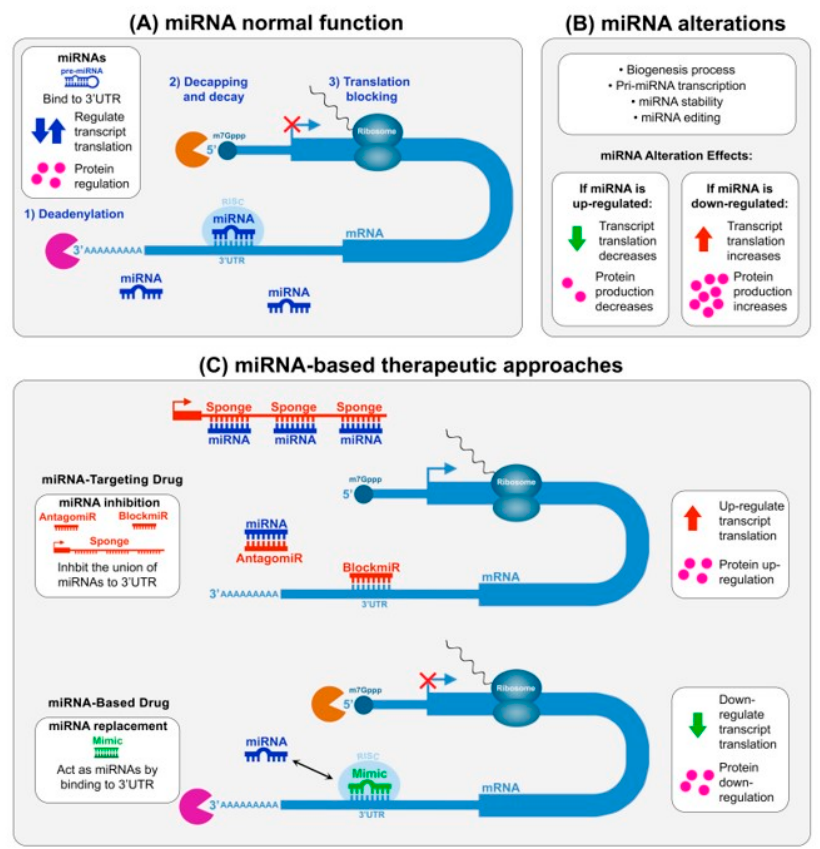
Figure 1. Micro RNA (miRNA) mechanisms for mRNA translation, regulation, and therapeutic intervention. ( A ) miRNA normal function. In mammals, the interaction between miRNA (in blue) and mRNA targets trigger di ff erent mechanisms for transcript regulation through the RISC complex